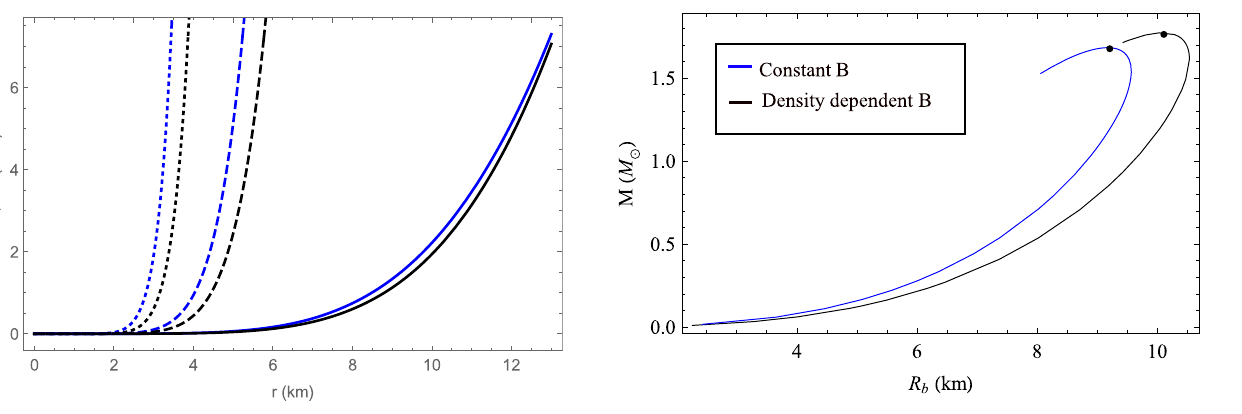
Fig. 24 Radial variation of M 2 and Q 2 inside PSR J1614-2230. Here blue and black curves correspond to plots of M 2 and Q 2 respectively. Solid, dashed and dotted curves correspond to D = 4, D = 5 and D = 6 respectively. To obtain these plots we have considered pressure isotropy condition and set γ = 0 . 4